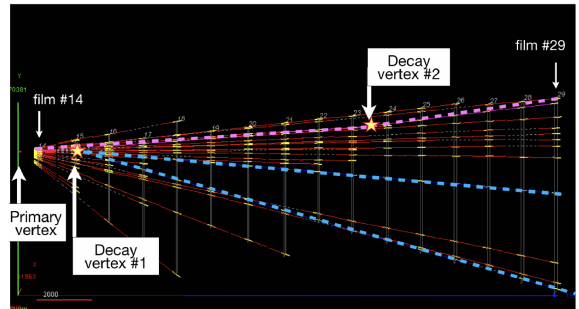
Figure 9. A double charm candidate event produced in proton collisions with the lead